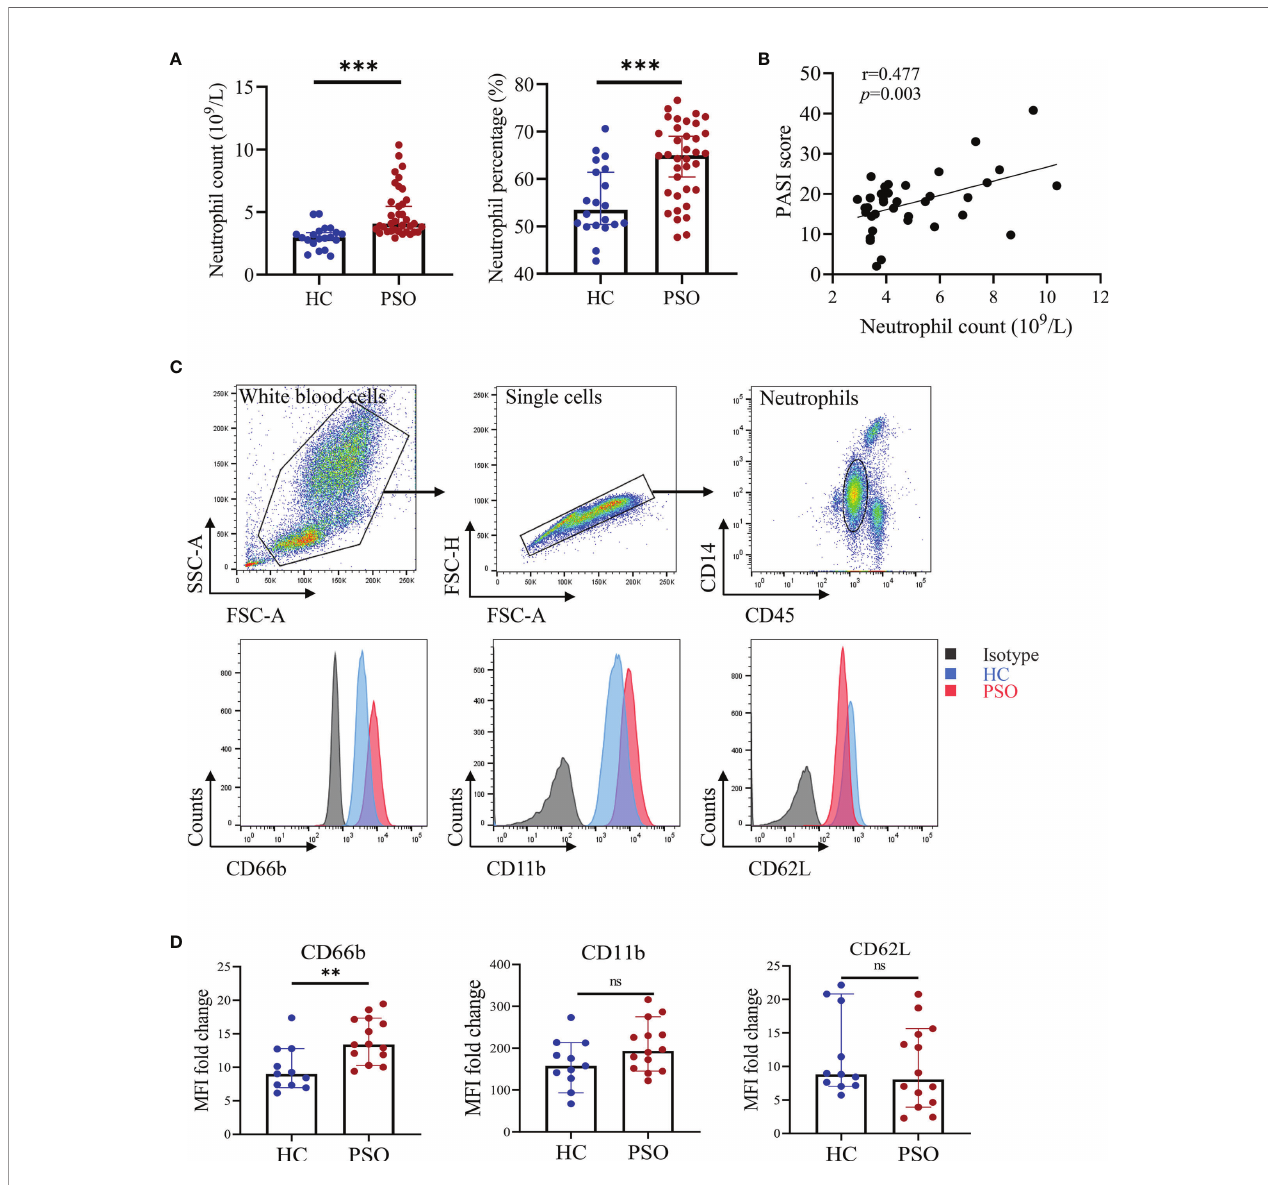
FIGURE 1 | Blood neutrophils are increased and pre-activated in psoriasis patients. (A) Absolute numbers and percentages of neutrophils (in white blood cells) in peripheral blood of healthy controls (HC, n = 20) and psoriasis patients (PSO, n = 36). (B) The correlation of the absolute numbers of blood neutrophils and PASI score in psoriasis patients (n = 36). (C) Representative fl ow plots showing gating strategy of blood neutrophils and CD66b, CD11b, and CD62L expressions in stained HC (blue) and PSO (red) samples versus isotype control (gray). (D) Fold changes of MFI (versus isotype) of CD66b, CD11b, and CD62L on neutrophils of HC (n = 11) and PSO (n = 14). Data are presented as median ± 95% CI. **p < 0.01; ***p < 0.001, by Mann – Whitney test. The correlation analysis was performed by Spearman correlation coef fi cient. CI, con fi dence interval; HC, healthy controls; MFI, median fl uorescence intensity; ns, not signi fi cant; PASI, psoriasis area and severity index; PSO,